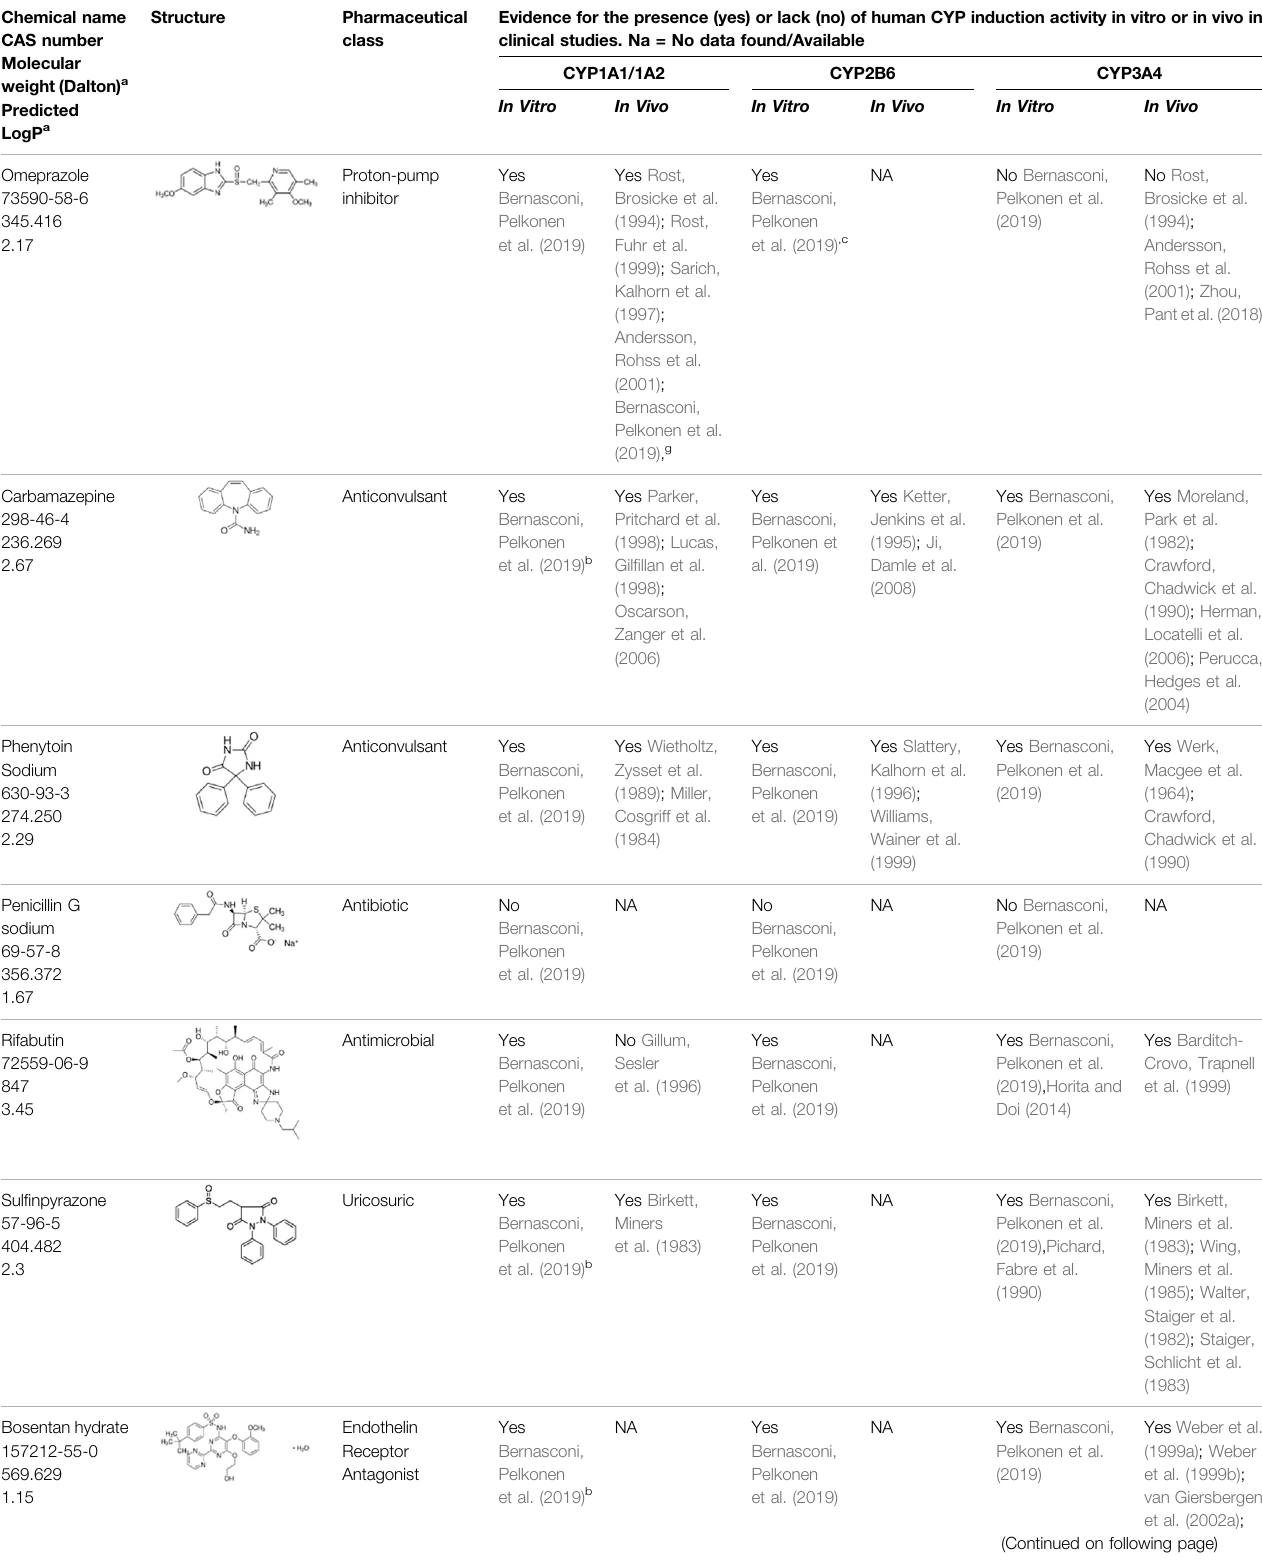
TABLE 2 | Set of Pro fi ciency Pharmaceutical Chemicals that have been Evaluated in Experiments Carried out by Bernasconi, Pelkonen et al., 2019 to Validate the In Vitro CYP Induction Assay in Primary Human Hepatocytes and HepaRG